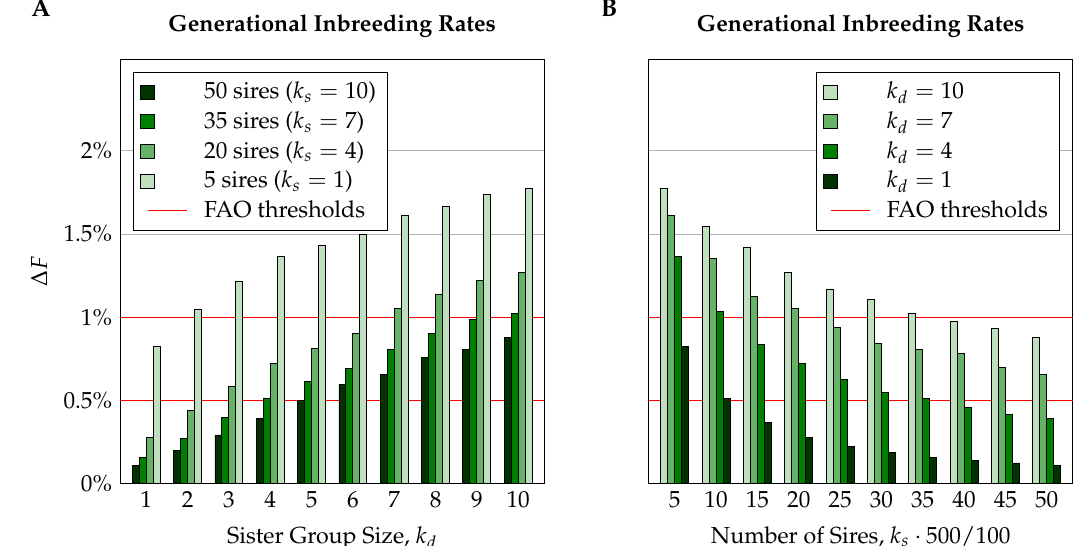
Figure 2. Generational inbreeding rates for different selection schemes on a population of N = 500 colonies per year for trait T − 0.53 with moderate negative correlation between maternal and direct 400 effects ( r md = − 0.53), influenced by 400 loci. The subfigures show the influences of different sister group sizes ( A ) and numbers of sires ( B ).